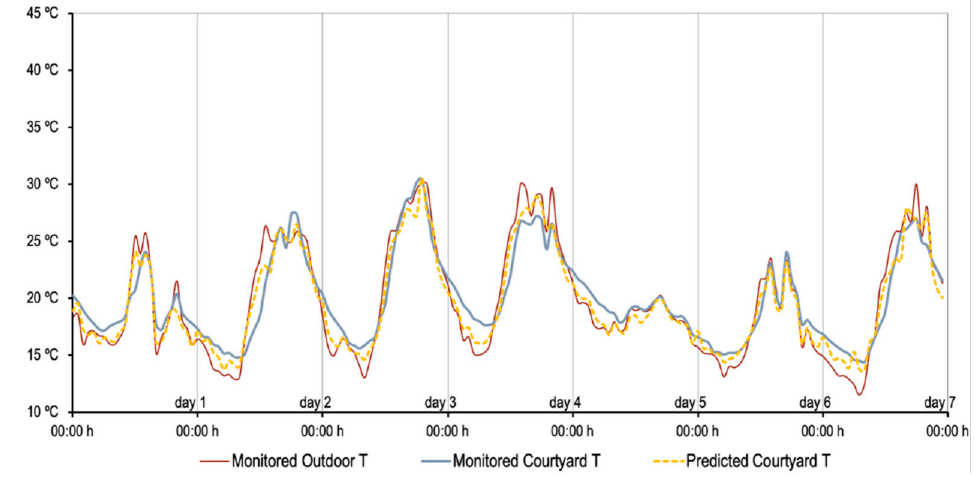
Figure 2. Example 3.0.1. Predicted temperature versus monitored and outdoor temperatures inside a TR1 courtyard.